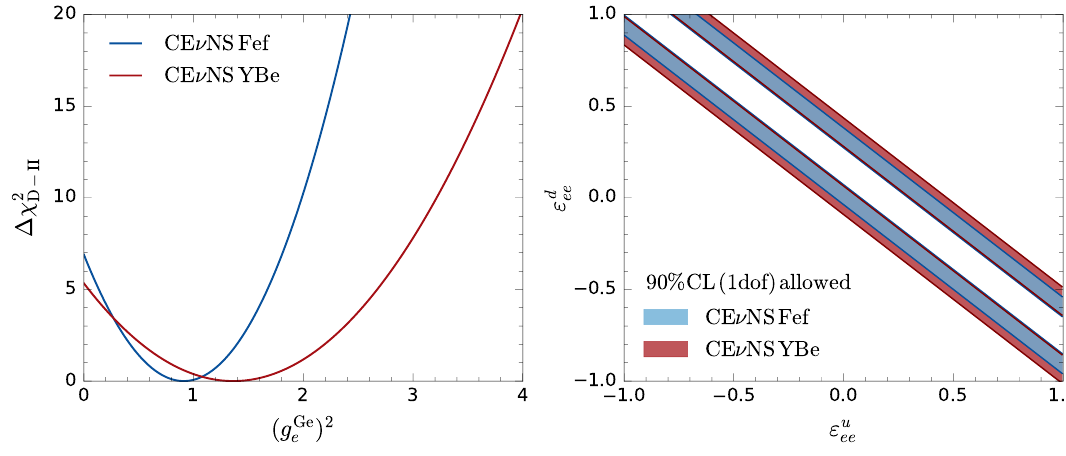
Figure 2 . Left panel: dependence of the profiled ∆ χ 2 relevant to CE ν NS of ¯ ν e scattering off the Ge detector of the Dresden-II experiment. Right panel: allowed regions at 90% CL (1 dof, two-sided, ∆ χ 2 = 2 . 71 ) in the ( ε u results are shown for two quenching factors, denoted by Fef (in blue), using iron-filtered monochro- matic neutrons, and YBe (in red), based on photoneutron source measurements [105]. Although not obvious, note that the allowed regions for the two quenching factors have one common side, so the Fef constraints are more